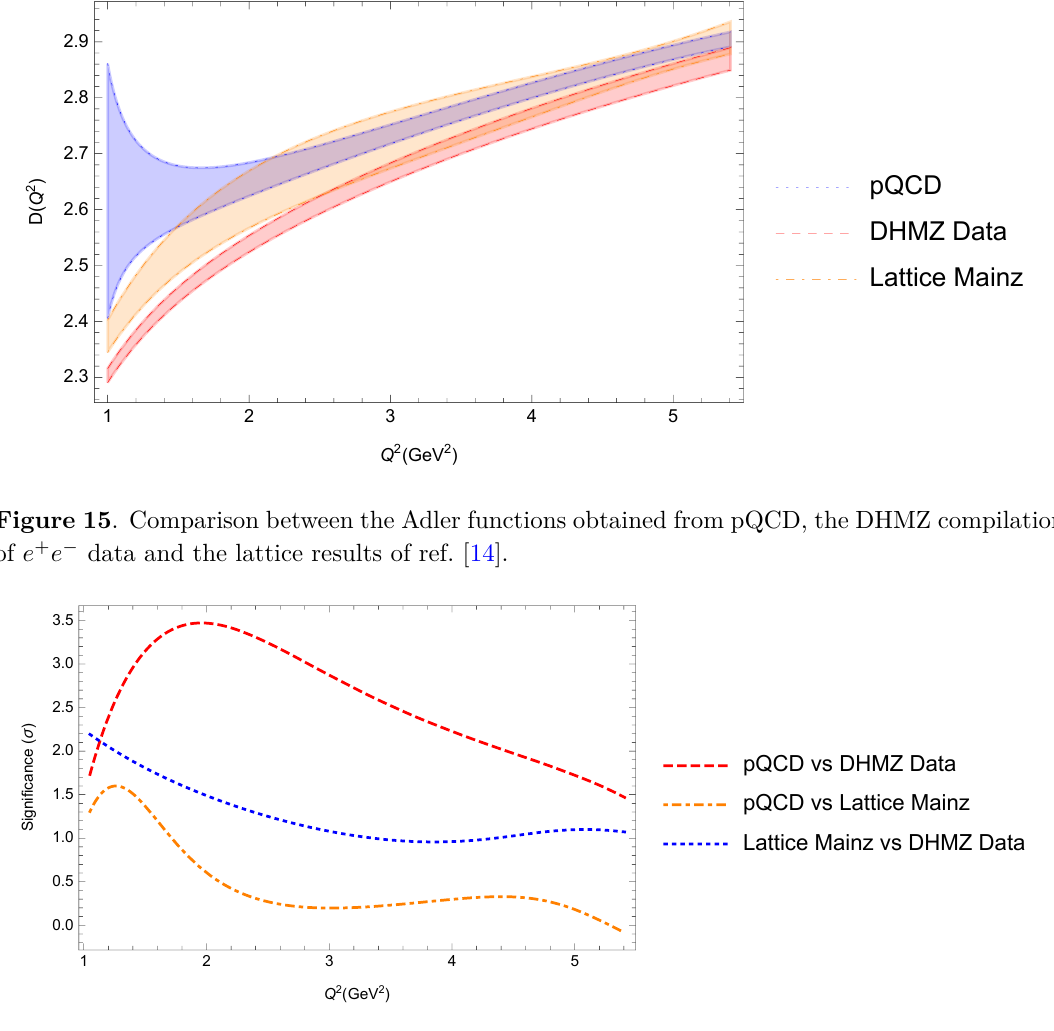
Figure 16 . Statistical significance of the differences between the three determinations of the Adler